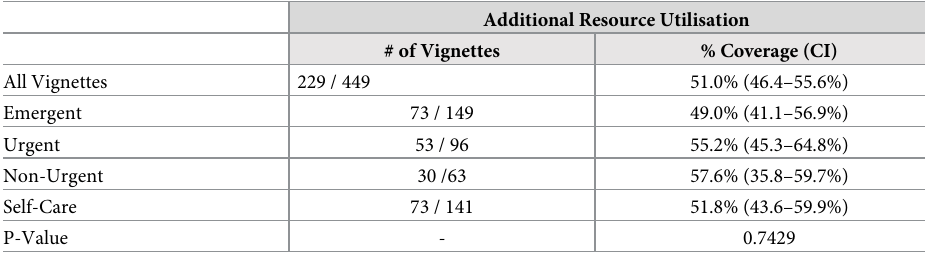
Table 4. Additional resource utilisation counts and